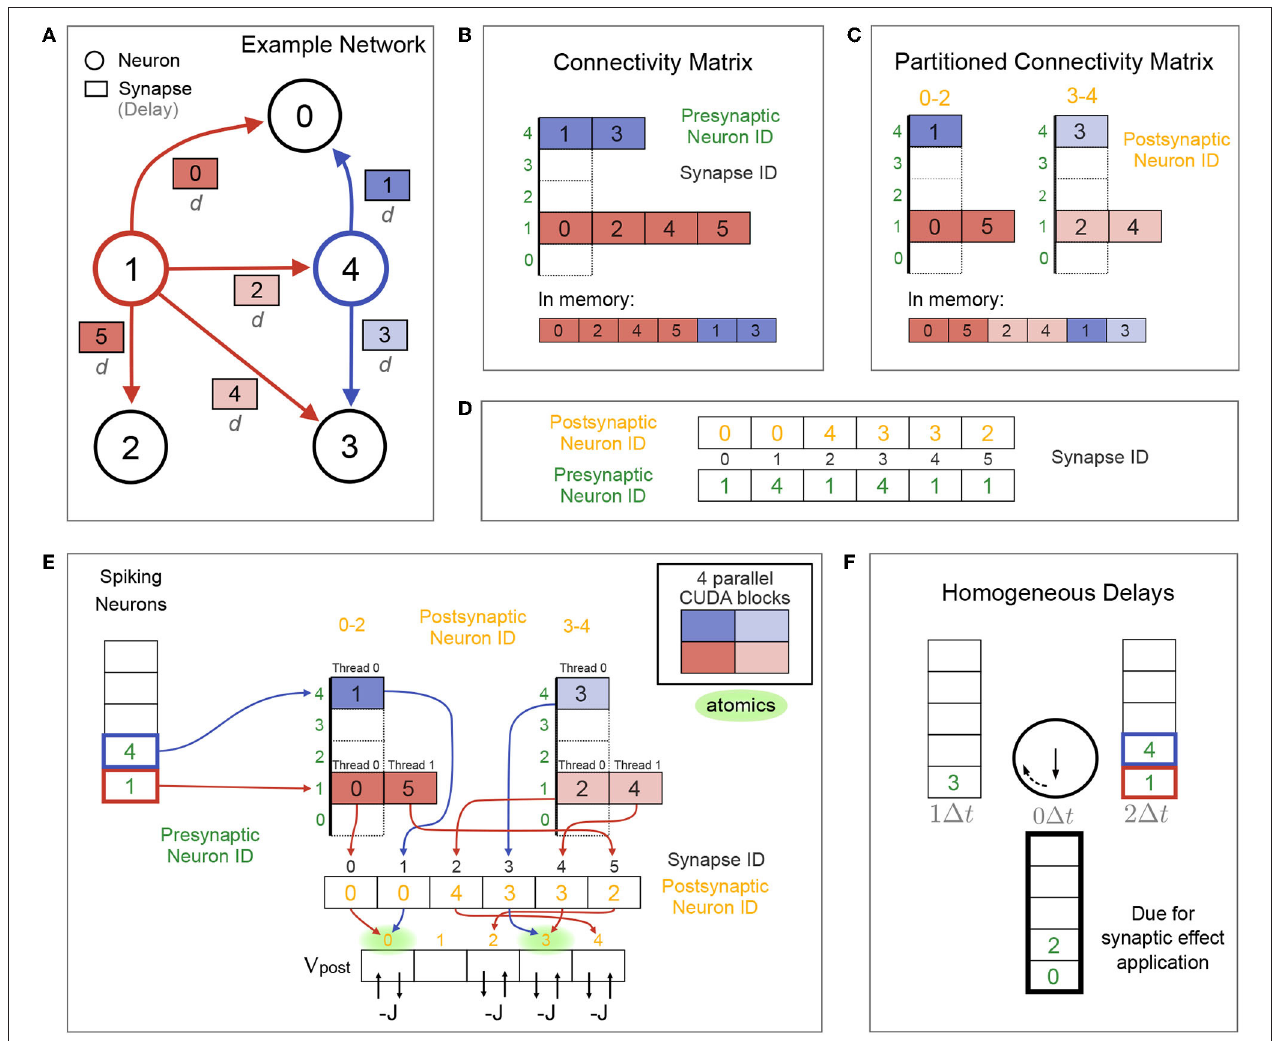
FIGURE 3 | Synaptic algorithm for networks with no or homogeneous delays. (A) Example connectivity for the recurrent network from Figure 1 , restricted to homogeneous synaptic transmission delays d and N = 5 neurons. Colored neurons 1 and 4 are spiking in the current time step. Color of their synapse IDs correspond to the parallelization over CUDA blocks in (E). (B) Connectivity stored in compressed form (YALE format) in global GPU memory as one concatenated array of synapse IDs sorted by presynaptic neuron ID (bottom view). Top view shows this array split by presynaptic neurons for visualization. Two additional arrays (not shown) store the start indices and number of synapses in the synapse array for each presynaptic neuron. Coloring correspond to the parallelization over CUDA blocks in (E). (C) Connectivity matrix for two postsynaptic neuron partitions, visualized as in (B). Each color shows one synapse group, defined by presynaptic neuron (red or blue) and postsynaptic partition (bright or dark). The synapse array is sorted in memory first by presynaptic neuron ID and then by partition (bottom view). (D) Pre- and postsynaptic neuron IDs for all synapses are stored in two arrays, sorted by synapses IDs. (E) Fully parallelized synaptic effect application for the network from (A) without delays ( d = 0 1 t ) and with the partitioned connectivity matrix from (C). Each of the 4 CUDA blocks (cf. colors) applies synaptic effects for all synapses of its respective synapse group. Membrane voltage updates are performed using CUDA’s atomic operations to avoid race conditions. Potential atomic conflicts at the same memory location are marked in green. Without connectivity matrix partionioning (B), only two CUDA blocks (one per spiking neuron) would process the synapses (not shown). (F) Circular list of spiking neuron arrays for the network from (A) with homogeneous delays d = 2 1 t . Spiking neuron arrays are labeled with the time in which their synaptic effects are due for application. Spiking neurons of the current time step are stored in the array labeled with d = 2 1 t . Synaptic effects are applied for the neurons in the array labeled with 0 1 t . After each time step, all array labels are rotated clockwise and the applied spiking neuron array will be overwritten by the new spikes of the next time